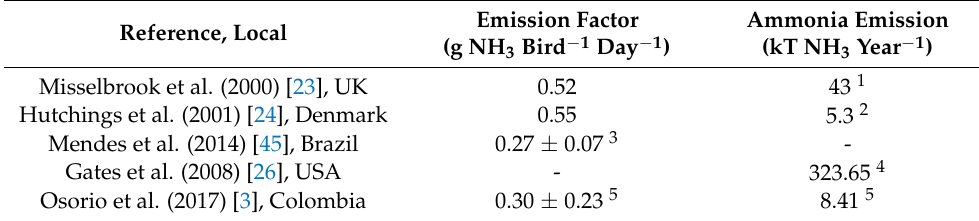
Table 1. Annual emission of ammonia (kT NH 3 year − 1 ) by poultry in several countries. Reference,